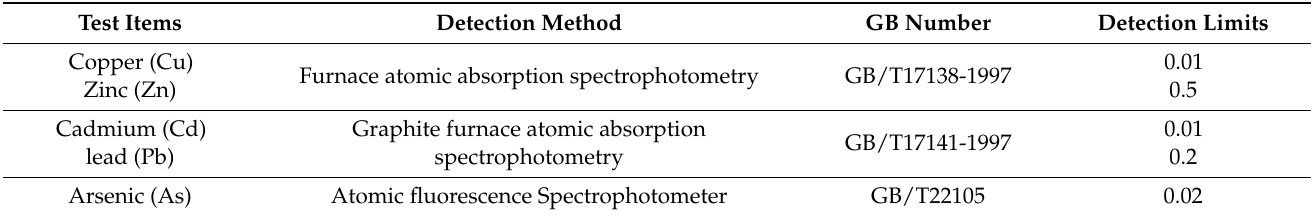
Figure 2. Geological maps of the study area. Table 1. Detection